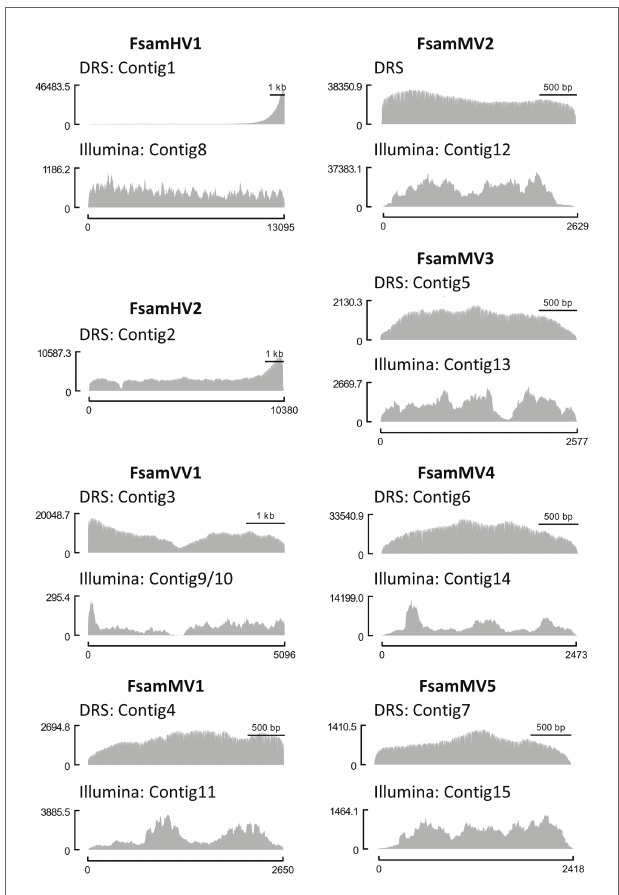
FIGURE 2 | Comparison of coverage uniformity between DRS and Illumina HiSeq. Genomic coverages of each viral contig from DRS (upper graph) and Illumina HiSeq (lower graph) visualized as histograms. The Illumina contigs of F. sambucinum hypovirus 1 (FsamHV1) and F. sambucinum mitoviruses (FsamMVs) and the DRS contig polished with Illumina reads of F. sambucinum victorivirus 1 (FsamVV1) were used as reference sequences for read mapping. The x -axis indicates the nucleotide position of a viral genome, and the y -axis indicates the coverage depth at each nucleotide